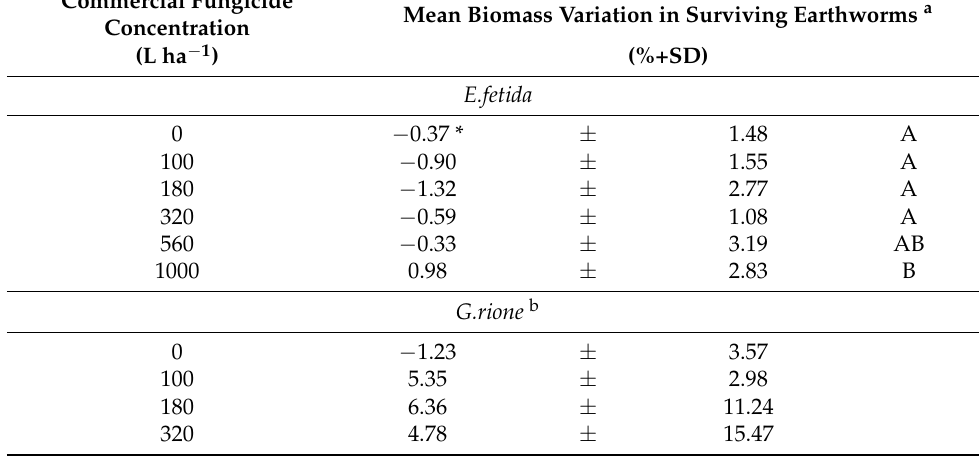
Table 7. Toxicity test 2. Mean individual biomass of Eisenia fetida and Glossoscolex rione (increase or decrease relative to biomass at start) ( ± SD) after 14 days’ exposure to PROSARO ® at different concentrations and in negative control (0 L ha − 1